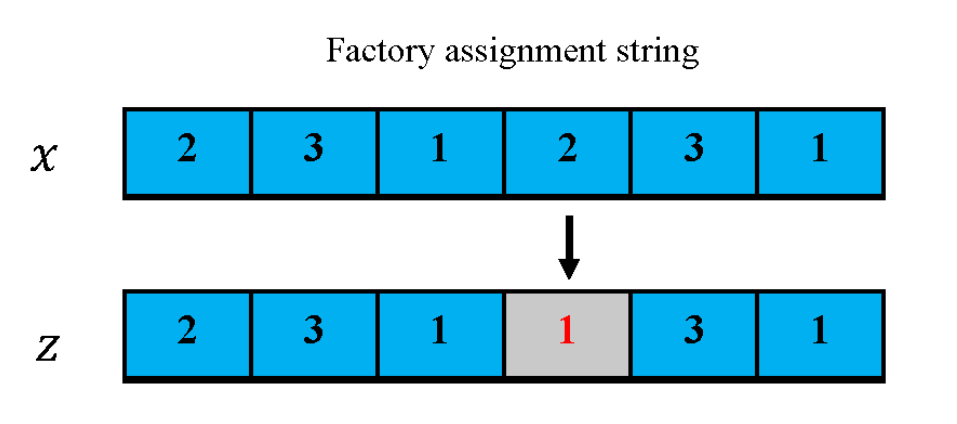
Figure 5. Example of N 7